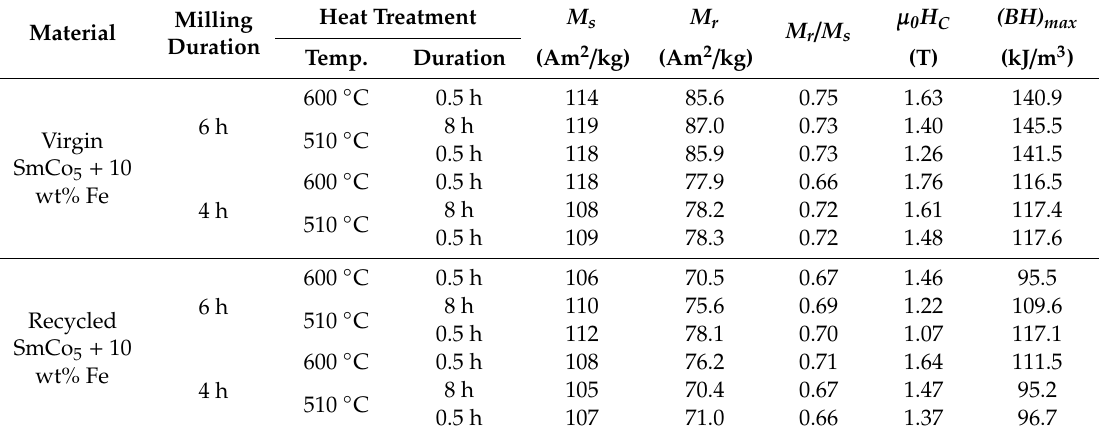
Table 2. Magnetic properties of 4 and 6h MM samples annealed at 510 and 600 ◦ C. Uncertainties in M s